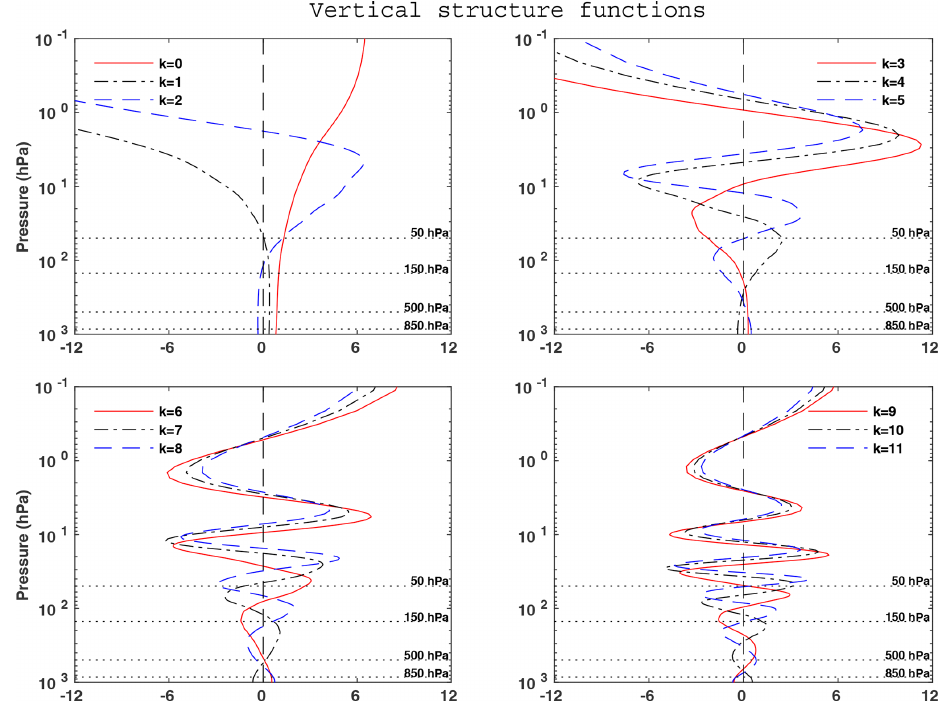
Figure 2. The first 12 vertical structure functions derived using T 0 and S 0 of Fig. 1 with boundary conditions (14) and (15).